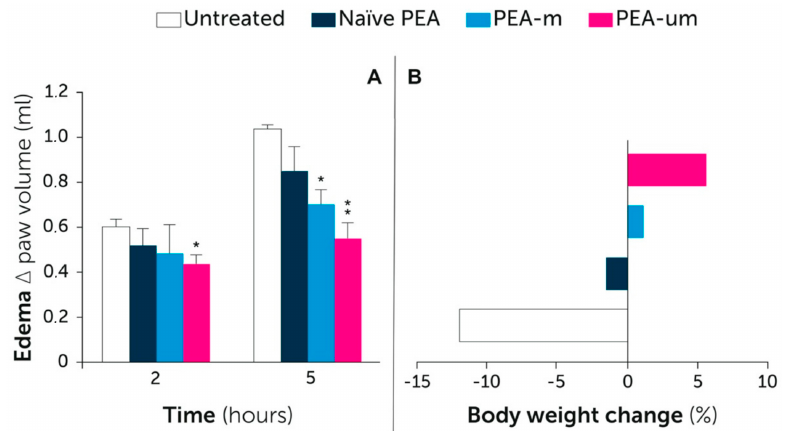
Figure 6. Superior activity of PEA-um compared to other PEA formulations. (A) E ff ect on inflammatory edema. Only the most relevant time points are depicted. See text for further details. * p < 0.05 and ** p < 0.01 vs. untreated group. Modified from [124]. (B) E ff ect on colitis-induced change in body weight. Modified from [125]. Naïve PEA: non-micronized PEA; PEA-m: micronized PEA; PEA-um: ultramicronized